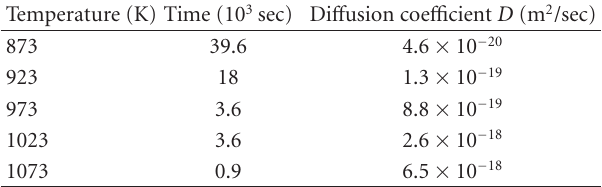
Table 3: Di ff usion coe ffi cients of Si in D9.